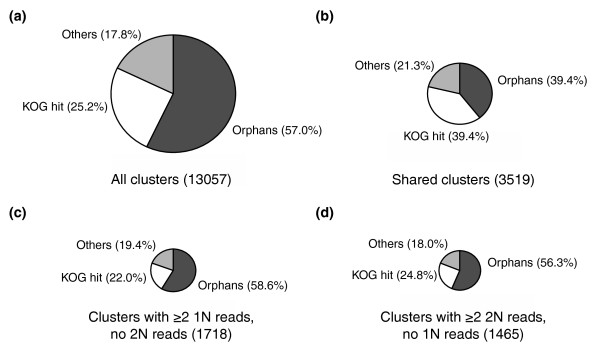
The proportion of orphan clusters. Non-orphan clusters that do not have hits in the KOG database are also represented (Others). (a) All clusters. (b) Shared clusters composed of reads in both 1N and 2N libraries. (c) Potentially 1N-specific clusters composed of two or more reads in the 1N library but zero in the 2N library. (d) Potentially 2N-specific clusters composed of two or more reads in the 2N library but zero in the 1N library.